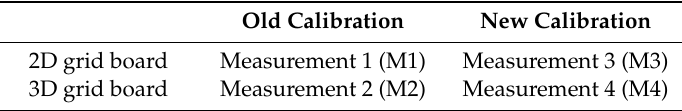
Table 6. Labels for individual measurement results.